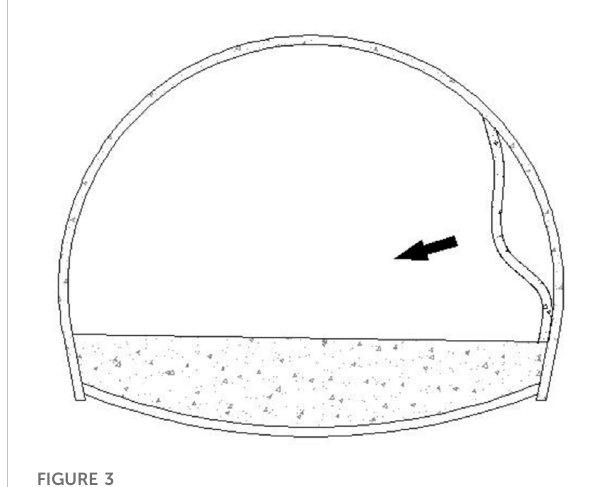
FIGURE 3 Plastic bulge of the initial support sidewall (Schematic diagram).